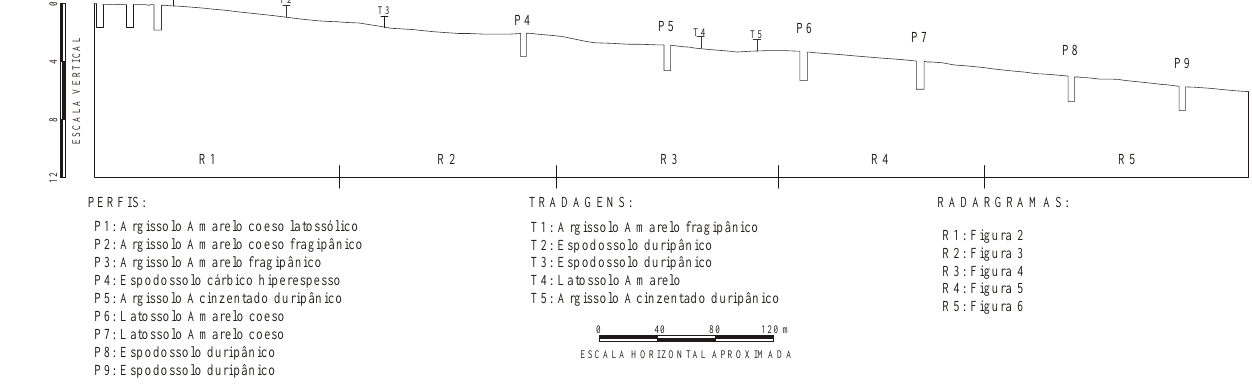
Figura 1. Toposseqüência esquemática de Entre Rios.